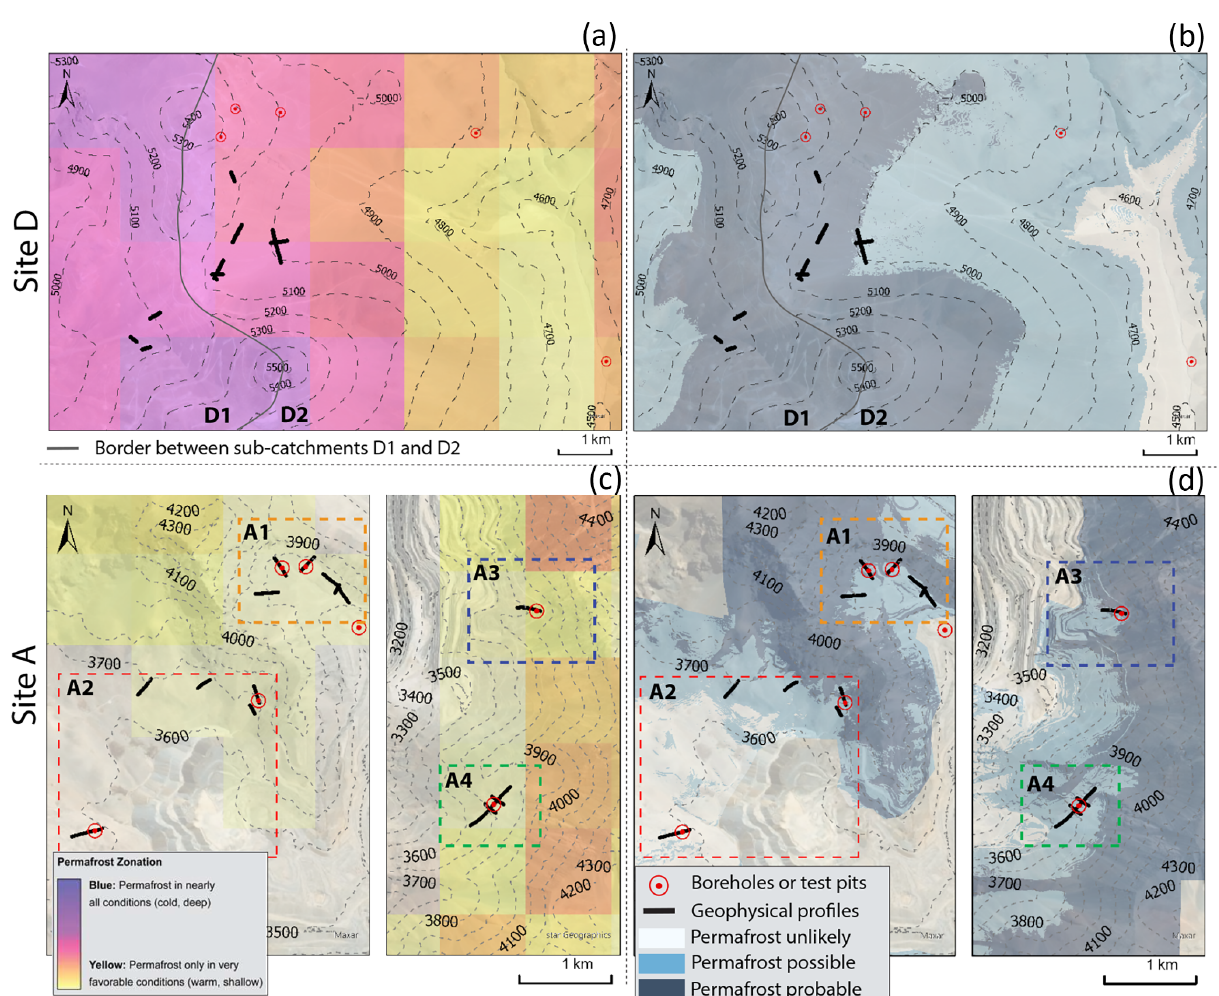
Figure 3. Comparison of the permafrost distribution model developed in this study ( b, d ; DEM 5m resolution) with the PZI model by Gruber (2012) ( a, c ; based on SRTM30 data set, < 1km resolution). Locations of boreholes (Site A) and test pits (Site D) are marked by red points on all maps. Map data: DigitalGlobe, accessed in Global Mapper V22 (Blue Marble Geographics), date